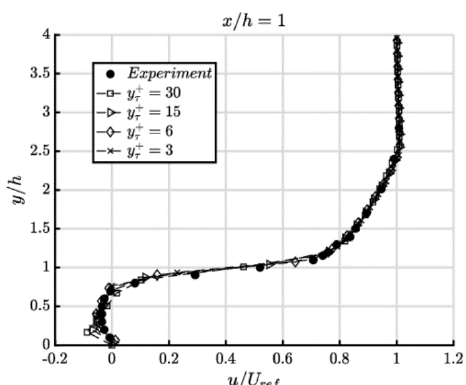
Figure 2. The friction coefficient ( C f ) over the lower wall( x/h = -5 to 35) comparison to experiments. Solid circles are experimental measurements of Driver and Seegmiller [50]. Lines represent simulation results with symbols: square – y t + = 30, triangle – y t+ = 15, diamond – y t+ = 6, and x – y t+ = 3.